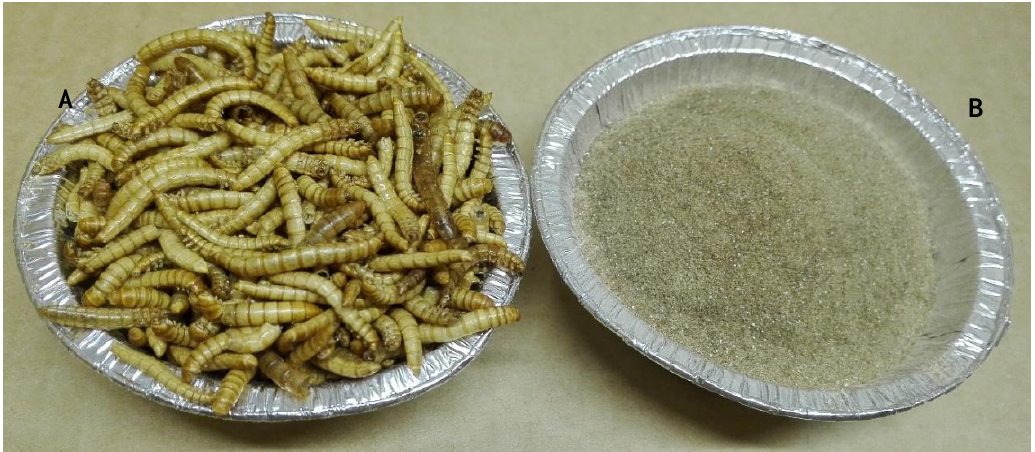
Figure 3. Yellow mealworm larvae ( A ) freeze-dried whole and ( B ) milled and freeze-dried. Photo by Xue Zhao, SLU, Sweden. Table 2. Summary of some insect species that are eaten as